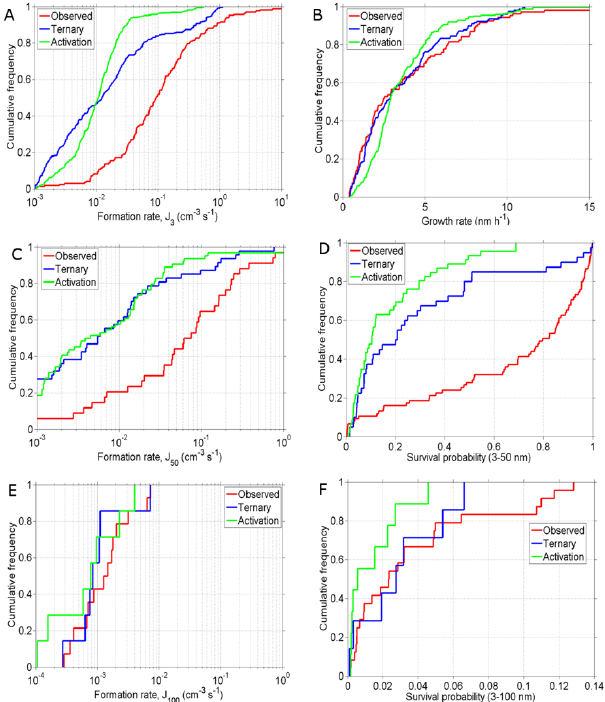
Fig. 6. Same as in Fig. 5, for modeled and measured nucleation metrics at Hyyti¨al¨a (HYY).